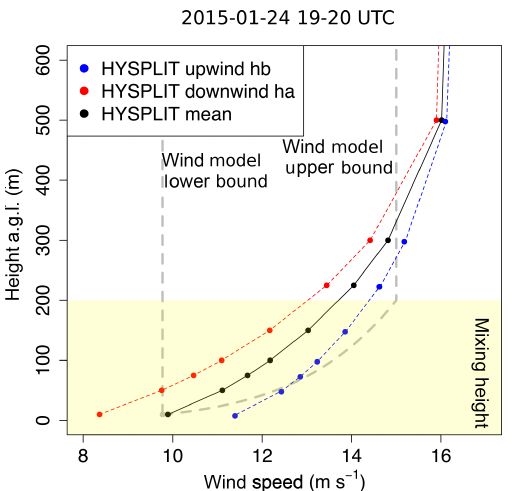
Figure E2. Comparison between our wind model and HYSPLIT simulations of wind speeds at different altitudes. The simulated mean wind profile (black curve) over Chino area is the averaged values of the profiles above the upwind site hb (blue curve) and the downwind site ha (red curve). The grey lines provide the range of our wind